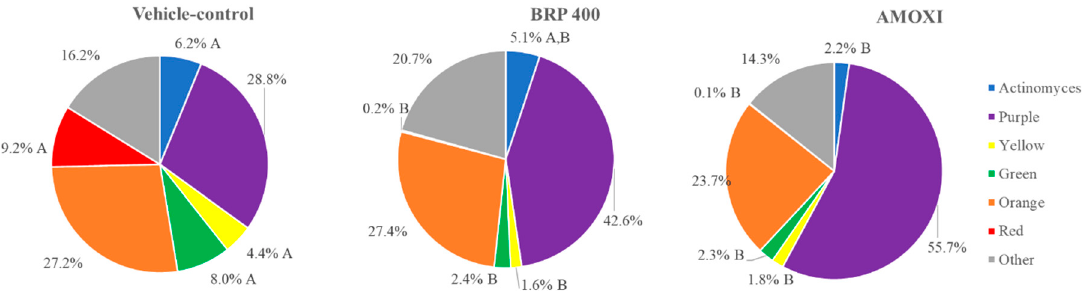
Figure 3. The e ff ects of Brazilian Red Propolis (BRP) extract, amoxicillin (AMOXI) and vehicle control on the proportion of bacterial complexes. The colors represent di ff erent microbial complexes as described by Socransky et al., 1998. The data were analyzed by Kruskal–Wallis followed by Dunn’s post-hoc test. Di ff erent letters indicate significant di ff erences between groups within the same bacterial complex ( p ≤ 0.05).